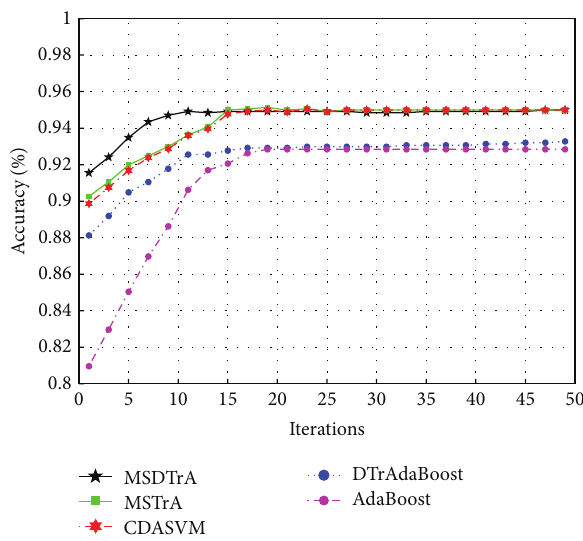
Figure 2: The classification performance on the target